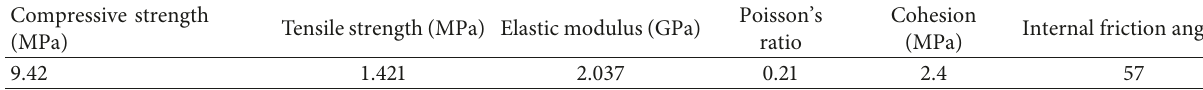
Table 5: Rock mechanics parameters for numerical simulation.